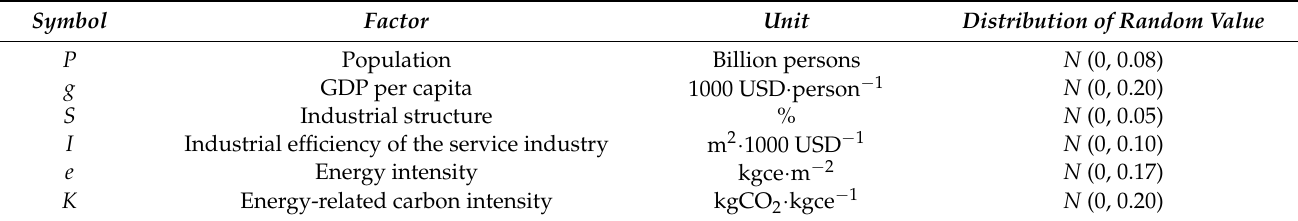
Table 1. Variable definitions in the emissions scenario